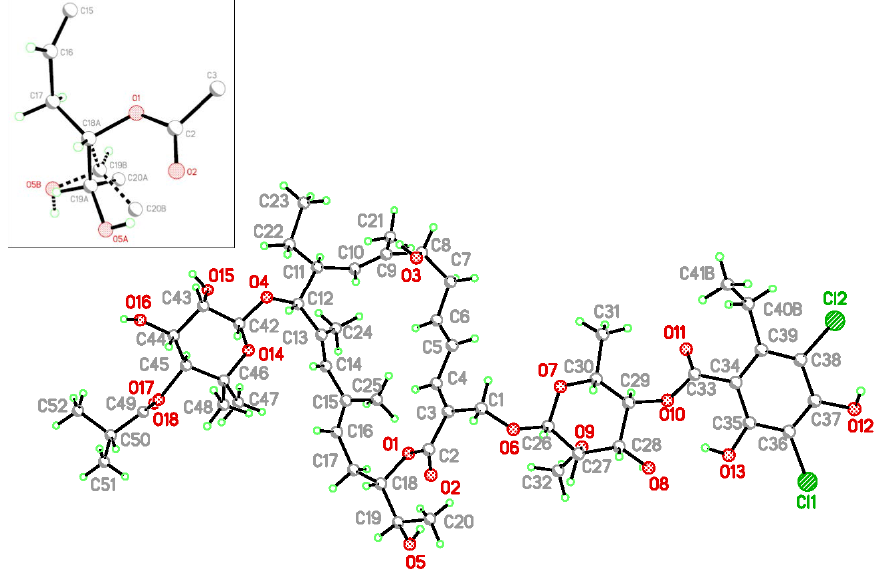
Figure 4. The molecular structure of lipiarmycin A3, showing the atomic labelling scheme. In the inset, a zoom is given of the two disordered positions of the C19 group, linked to C18 atom.